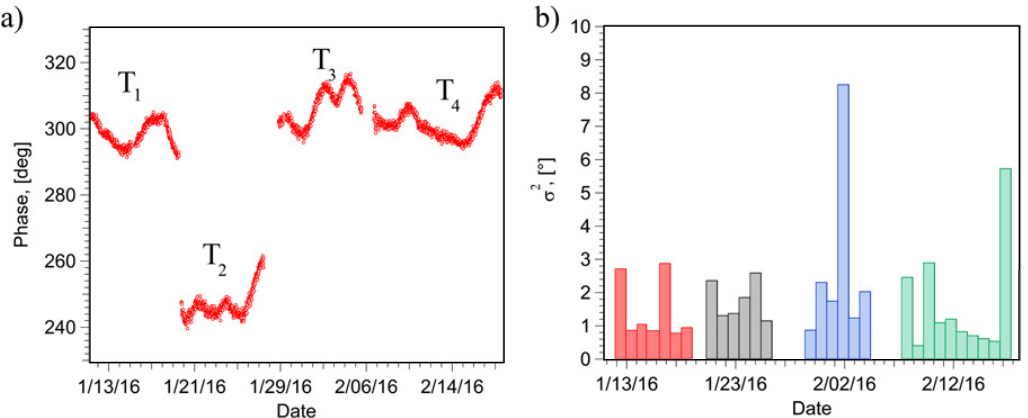
Figure 4. Current phase stability. a) Phase data taken over a period of several months. Each point represents the fitted φ from Eq. (5) taken every 21 minutes. b) The variance defined in Eq. (5) for the data in a). The temperature of the interferometer is controlled using a PID feedback loop. The four sections of phase/variance are for different control temperature